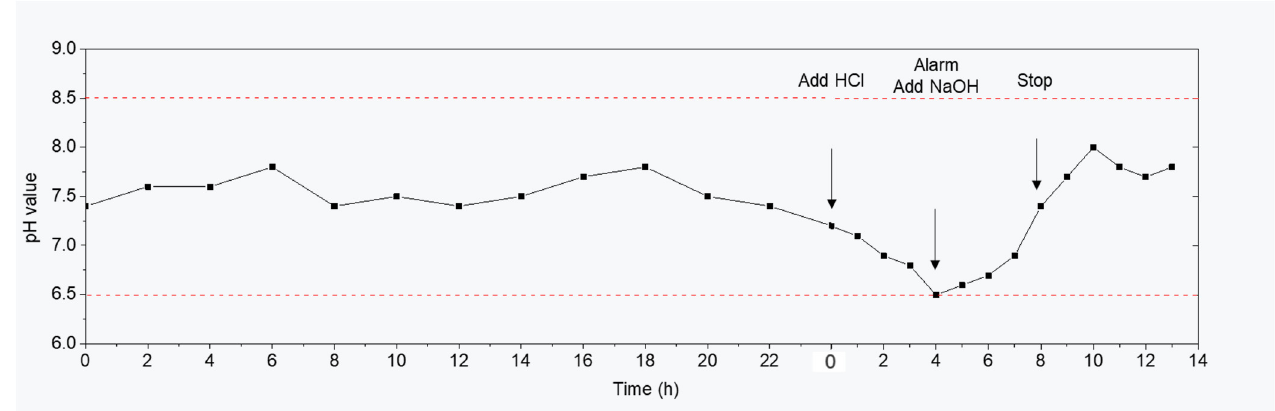
Figure 5. The pH change trend during acid-base adjustment.